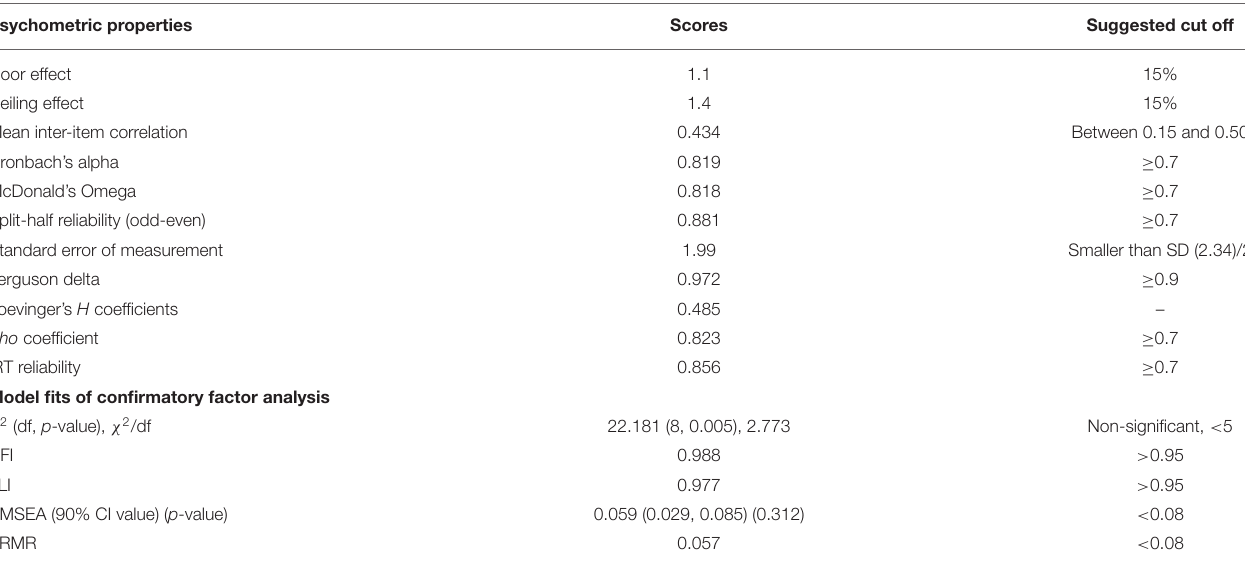
TABLE 3 | Scale-level psychometric properties of the SAVE-6 among cancer patients. Psychometric